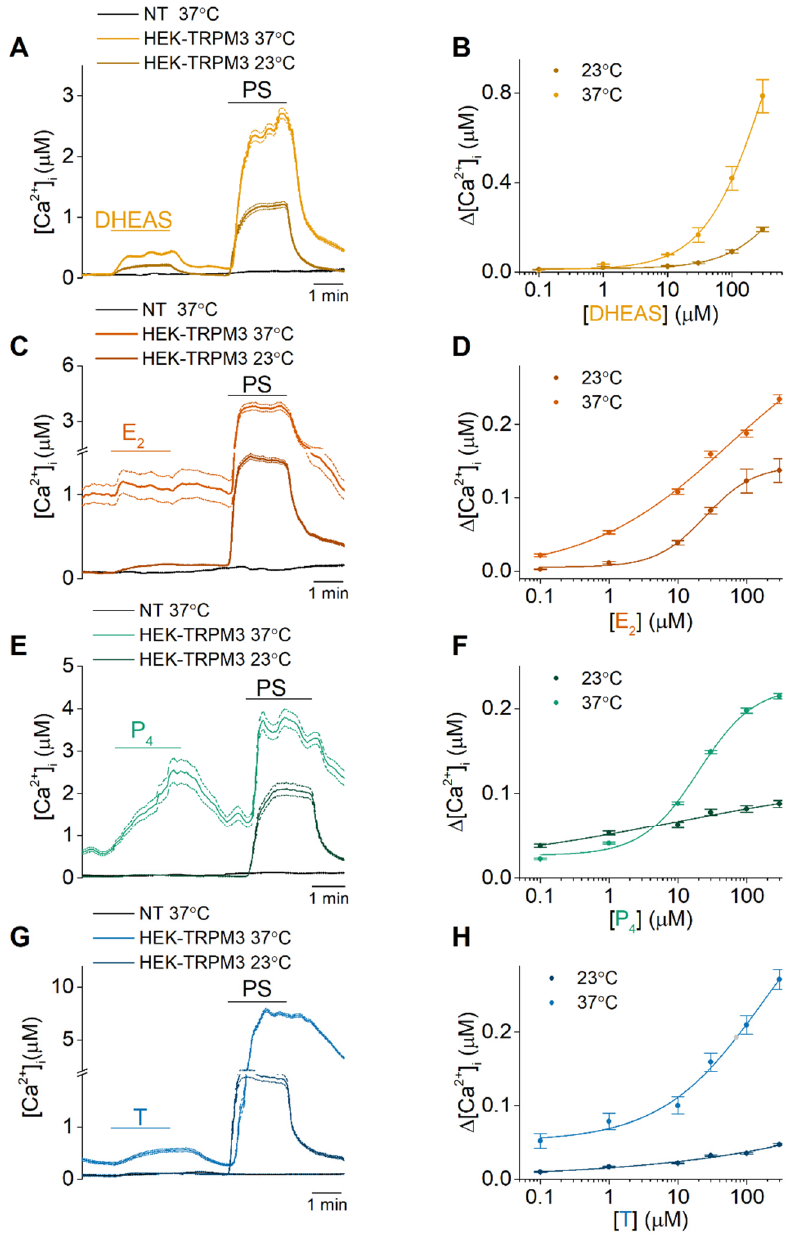
Figure 2. DHEAS, estradiol, progesterone, and testosterone act as weak TRPM3 agonists with increased TRPM3 activation at 37 °C. ( A , C , E , G ) Time course of intracellular calcium concentrations ([Ca 2+ ] i ) of HEK-TRPM3 and nontransfected HEK293T (NT) cells upon application of 300 µM DHEAS, E 2 , P 4 or T, respectively, followed by 40 µM PS. ( B , D , F , H ) Concentration-response curves of DHEAS (N = 4, n = 1973), E 2 (N = 4, n = 963), P 4 (N = 4, n = 602) and T (N = 5, n = 512) at 23 °C (grey) and of DHEAS (N = 3, n = 1457), E 2 (N = 4, n = 778), P 4 (N = 4, n = 964), and T (N = 5, n = 485) at 37 °C (colored trace). Data are represented as mean ± SEM.